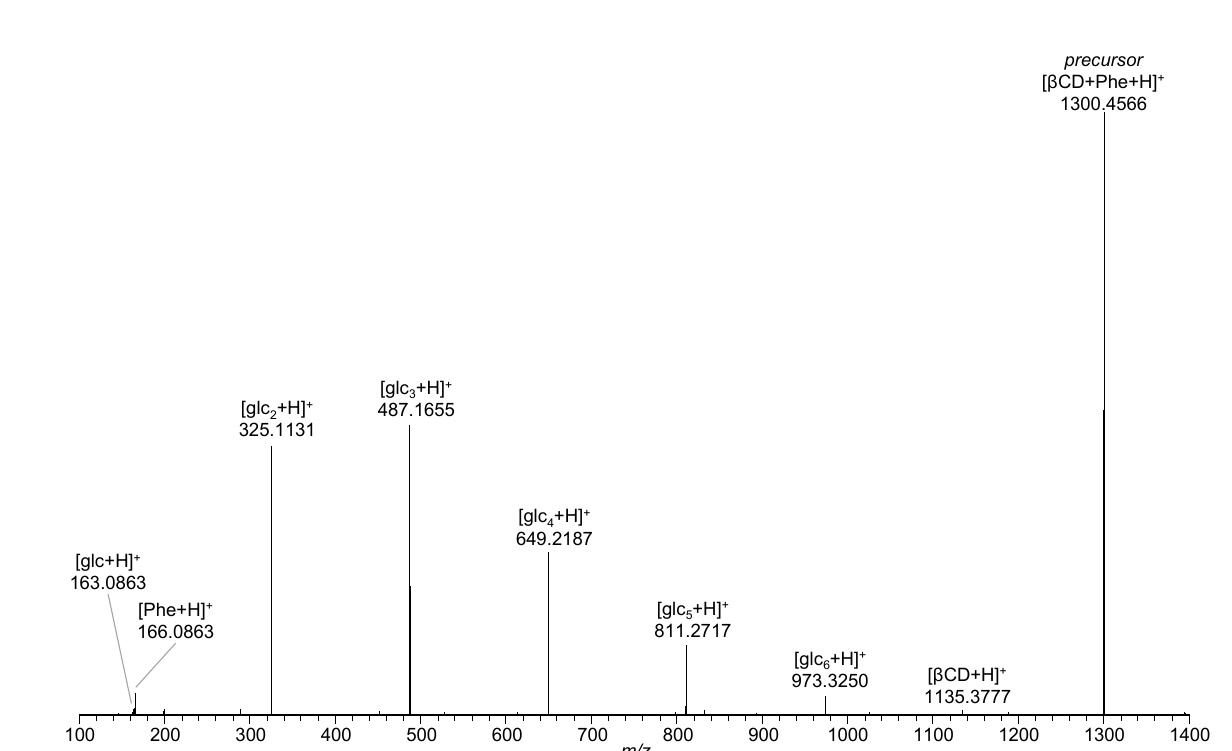
Figure 3. Higher energy collision induced dissociation (HCD) spectrum of [ β CD + Phe + H] + ( m / z 1300.48) at 37 eV (16% normalized collision energy (NCE)) showing the separation of the precursor ion into [Phe + H] + , [ β CD + H] + , and β -cyclodextrin fragment ions [glc n + H] + (n = 1–6).